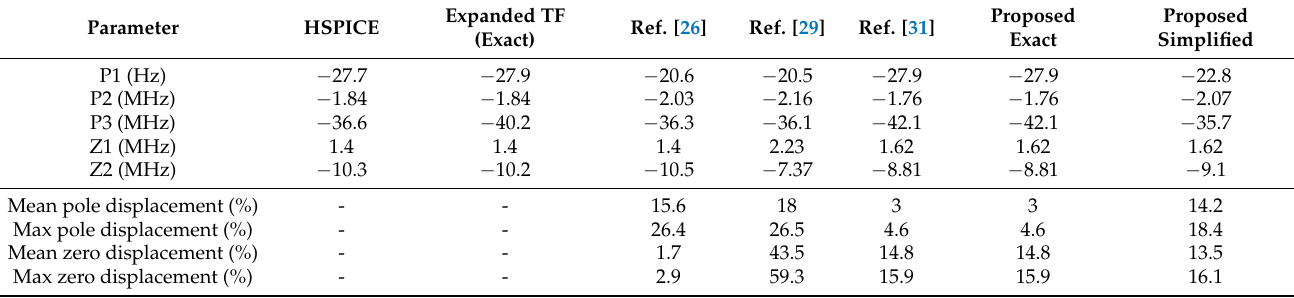
Table 9. Numerical results for Circuit 3.